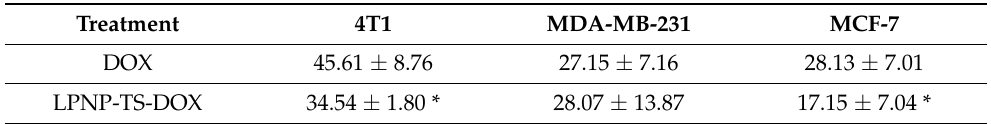
Table 4. Percentage of cell migration in relation to the control for 4T1, MDA-MB-231 and MCF-7 cell lines, when exposed to 500 nM of free or encapsulated DOX, for 24 h. The results were expressed as mean ± standard deviation (n = 3). Asterisks indicate statistically significant differences between the treatment groups in the same cell line ( p < 0.05).